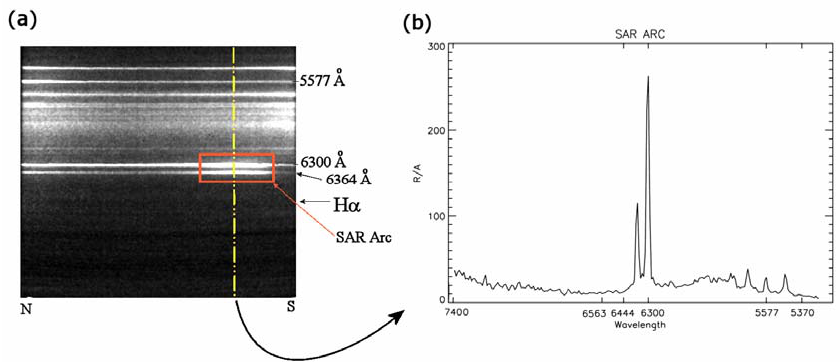
Figure 3. (a) A sample image from the meridional imaging spectrograph. The spatial Fig. 3. (a) A sample image from the meridional imaging spectrograph. The spatial location of the SAR arc is indicated by the red box, which location of the SAR arc is indicated by the red box, which encloses a encloses a pronounced bright “bulge” absent from other emission lines. The vertical yellow line refers to a 1-pixel width column taken at the pronounced bright “bulge” absent from other emission lines. The vertical brightest area of the SAR arc, plotted as a spectrum (R/ ˚A vs. wavelength) in (b) . yellow line refers to a 1-pixel width column taken at the brightest area of the SAR arc, plotted as a spectrum (R/Å vs. wavelength) in (b). data product is meridional brightness versus latitude (N-S), at many wavelengths simultaneously, throughout the